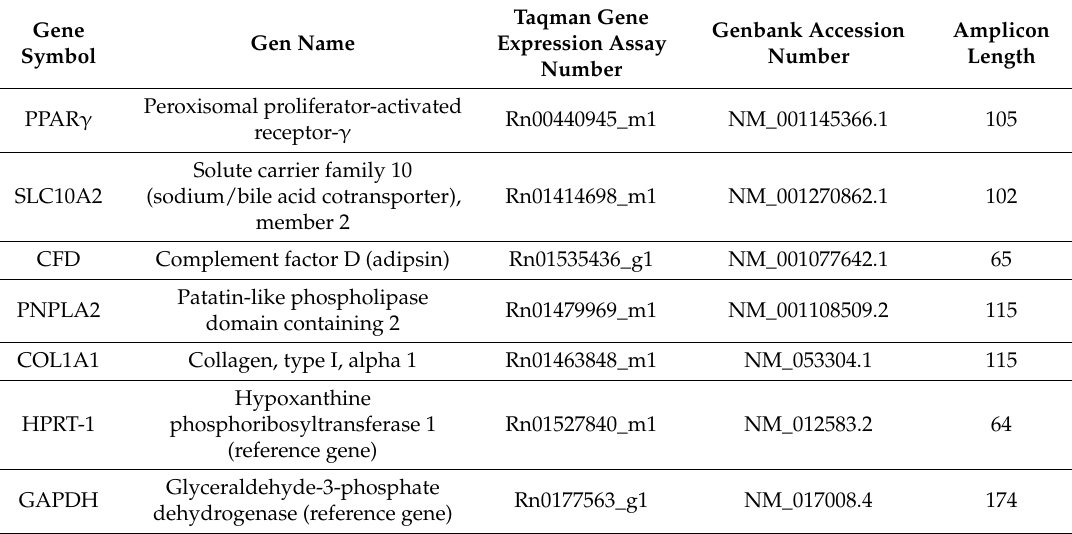
Table 1. Specifications and details of target and reference